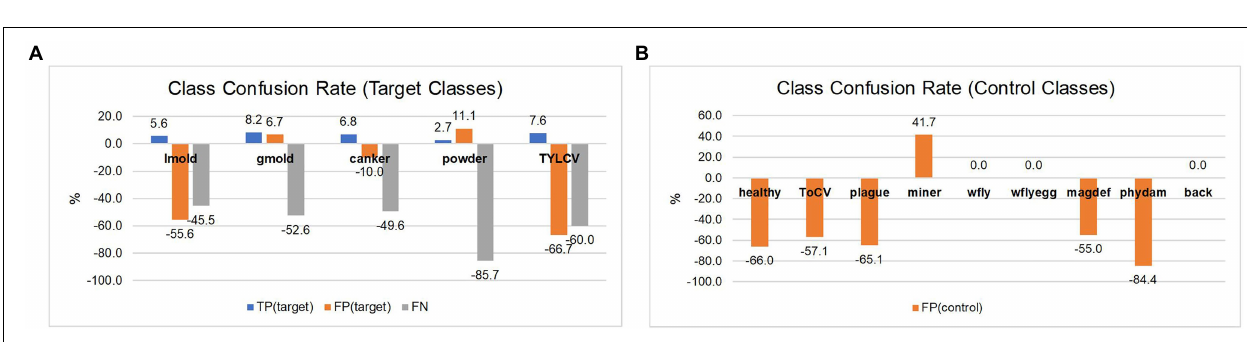
FIGURE 8 | Class confusion rates concerning the use of target and control classes. (A) Using control classes can effectively reduce the false positive and false negative rates in most target classes. (B) Also, the effect is extended to reduce confusion with data of control classes mainly. The impact appears to be more effective in classes with more similar features to the target ones. Class notations are introduced in Section “Criteria for Data